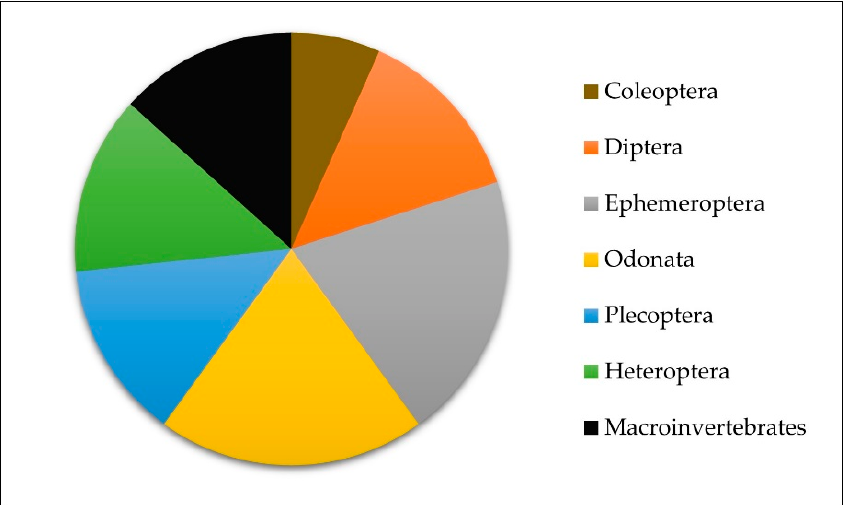
Figure 1. Aquatic insect orders investigated in studies published in the Diversity Special Issue: Aquatic Insects: biodiversity, ecology, and conservation challenges.